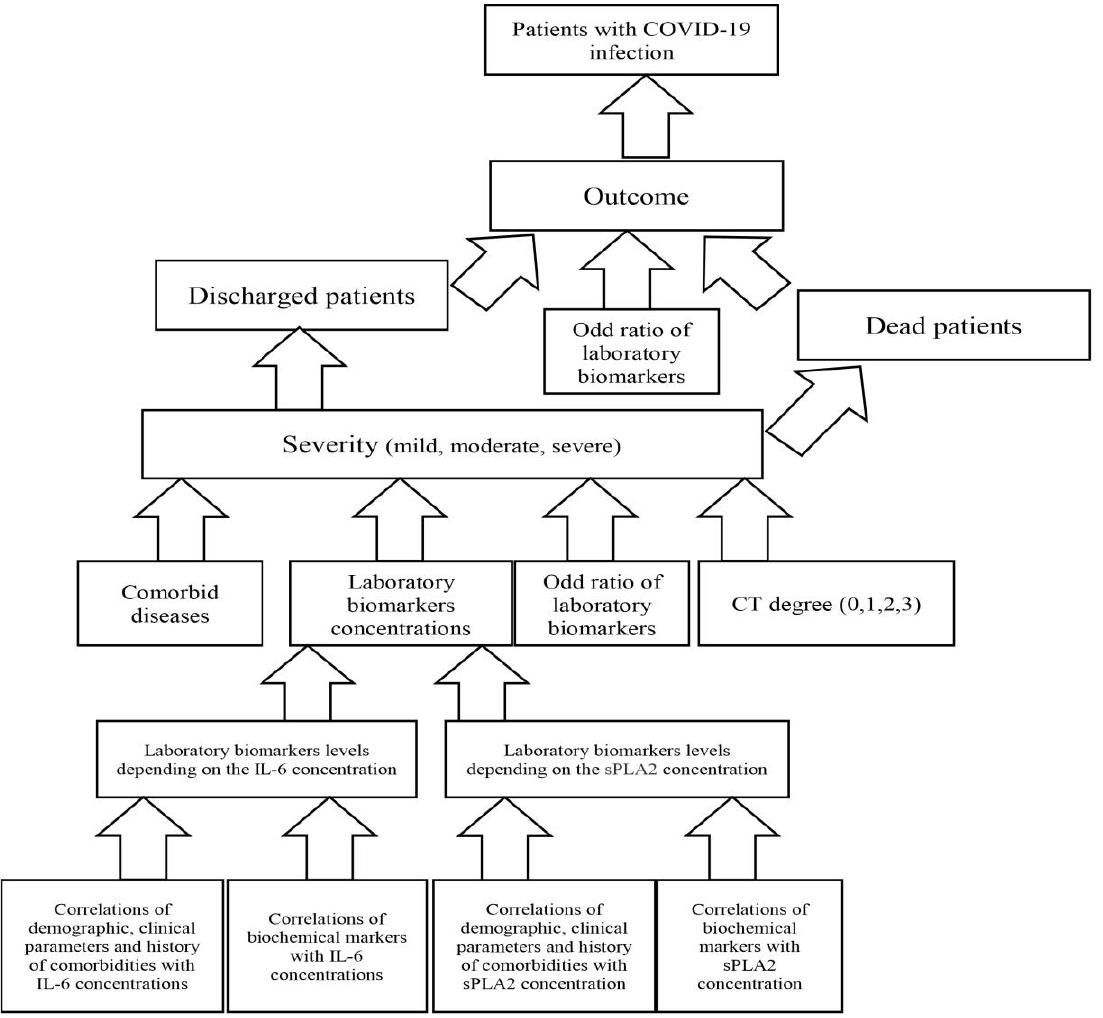
Figure 5. Design of the study.